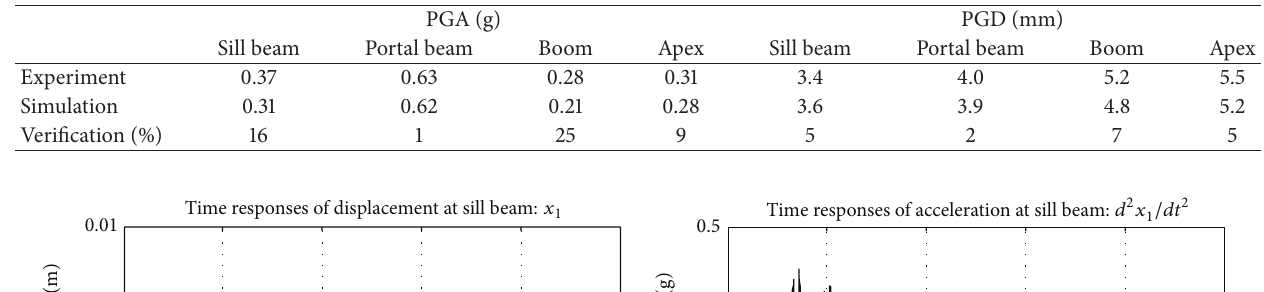
Table 7: Comparison of the PGA and PGD values of mathematical model and shake table test.